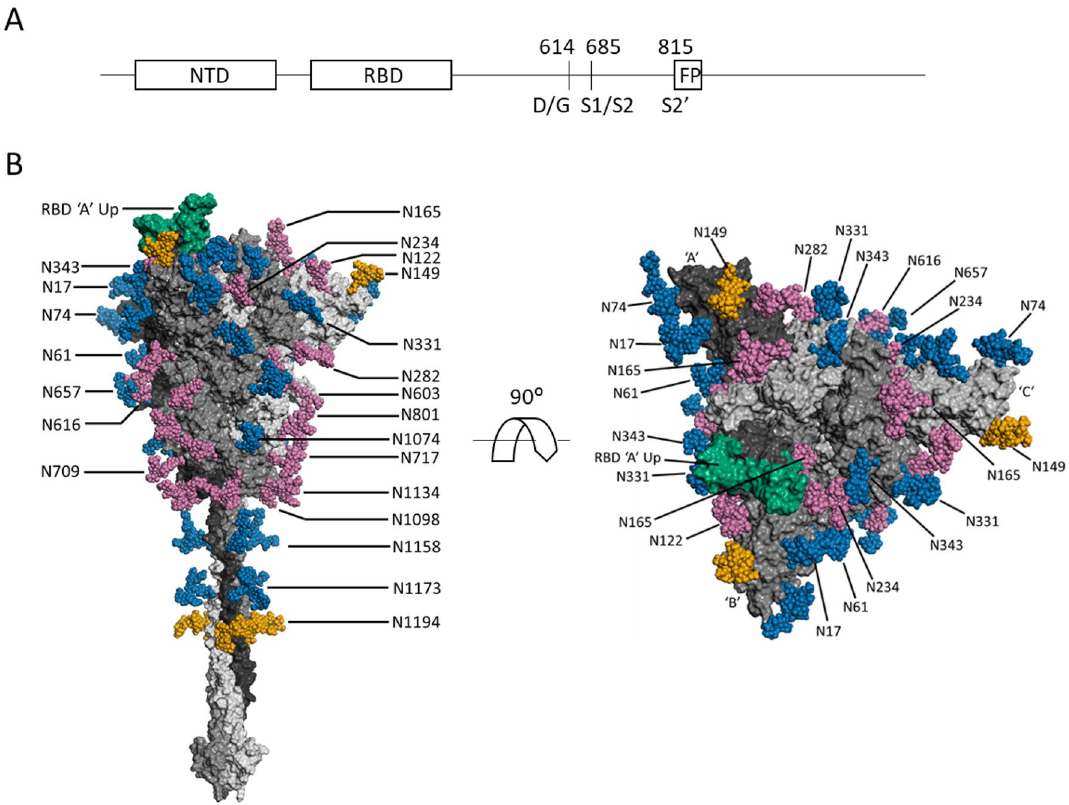
Figure 3. ( A ) Schematic SARS-CoV-2 S protein primary structure. ( B ) N-glycans depicted on a representative full-length, fully-glycosylated prefusion conformation of the trimetric SARS-CoV-2 spike protein (file 6vsb 1 1 1.pdb from the CHARMM-GUI Archive displayed in PyMOL) 36,37 . Blue-colored glycans indicate no change in the glycosylation site between the S-614G mutant and the S-614D wild type. Magenta-colored glycans indicate a modification in the glycan distribution and type between the mutant and wild type. The RBD is shown in green. The N149 and N1194 glycans are gold. The glycans depicted do not necessarily match those described in this report, and the O-linked glycans in the model are hidden due to low